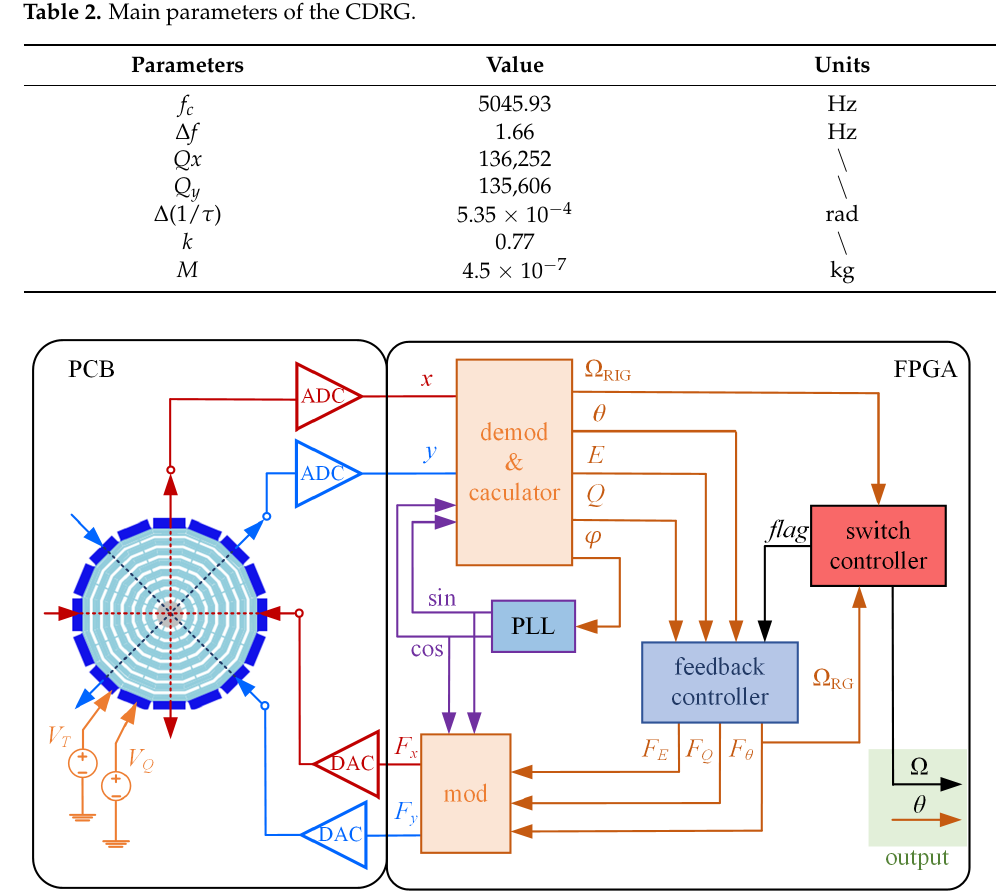
Figure 7. Block diagram of mode switching control system. The ‘demod & calculator’ module in the FPGA is used to demodulate and calculate the required control signals; the PLL module is used to track the resonant frequency of the gyro; the switch controller module is used to compare the angular rate and the preset rate and send the switching control flag ; and the feedback controller and ‘mod’ modules are used to generate and to modulate the feedback signals to the gyro. Table 2. Main parameters of the CDRG